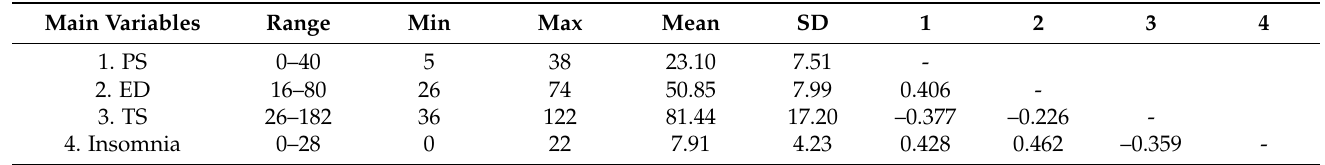
Table 2. Main characteristics of variables of interest and correlation coefficients between main